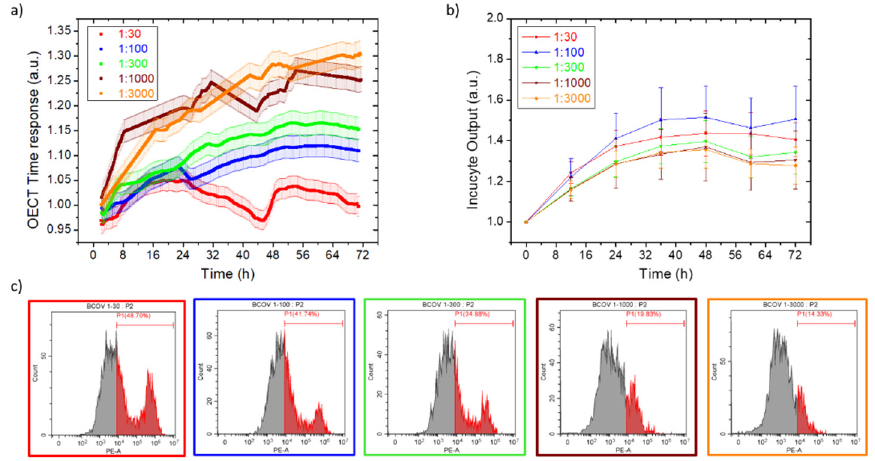
Figure 3. OECT ( a ) and Incucyte ® ( b ) real-time monitoring of HRT-18 cells, infected with progres- sively diluted B-CoV concentrations in suspension. Each OECT time response point is the average of five consecutive measurements, having the standard deviation reported as a curve shadow. ( c ) The cytofluorimeter analysis of the HRT-18 dead population after 72 h of B-CoV incubation, at increasing viral dilutions (from left to right).